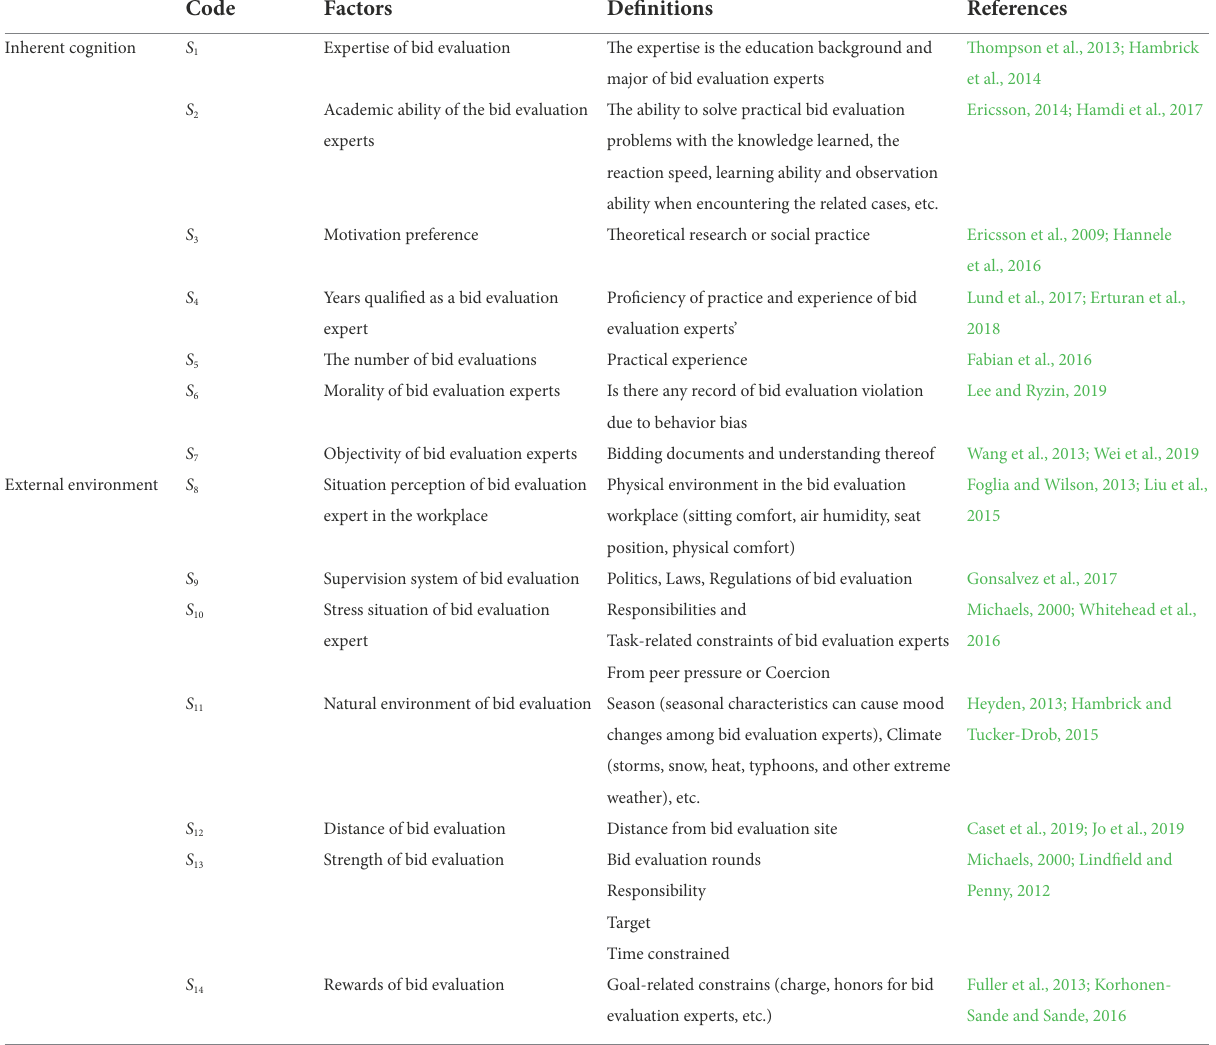
TABLE 1 Identification of expert performance factors per dimension.